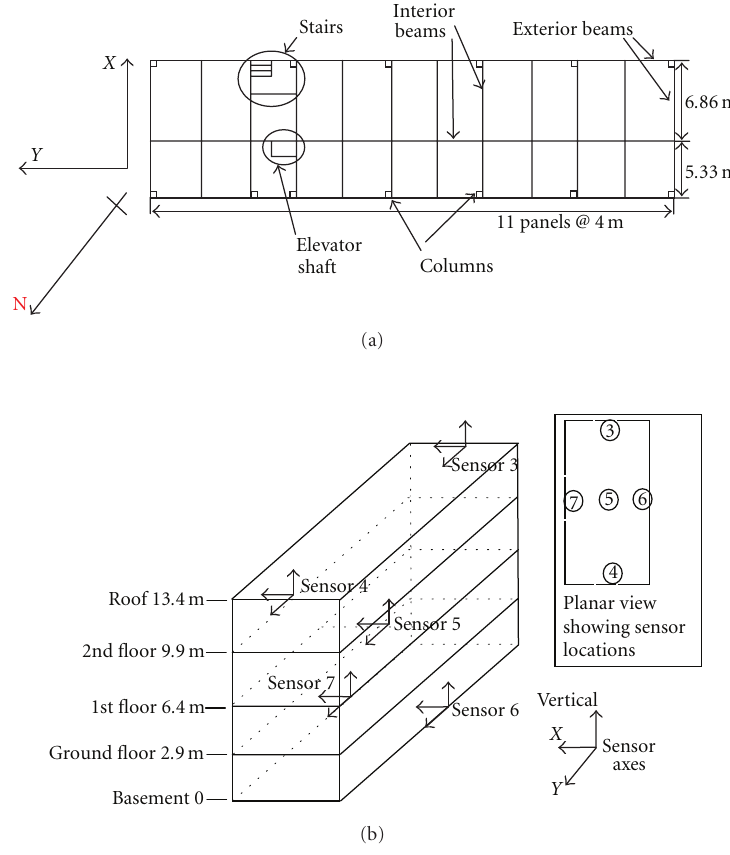
Figure 2: Building A: (a) typical floor plan showing location of stairs and elevator shaft and (b) sensor